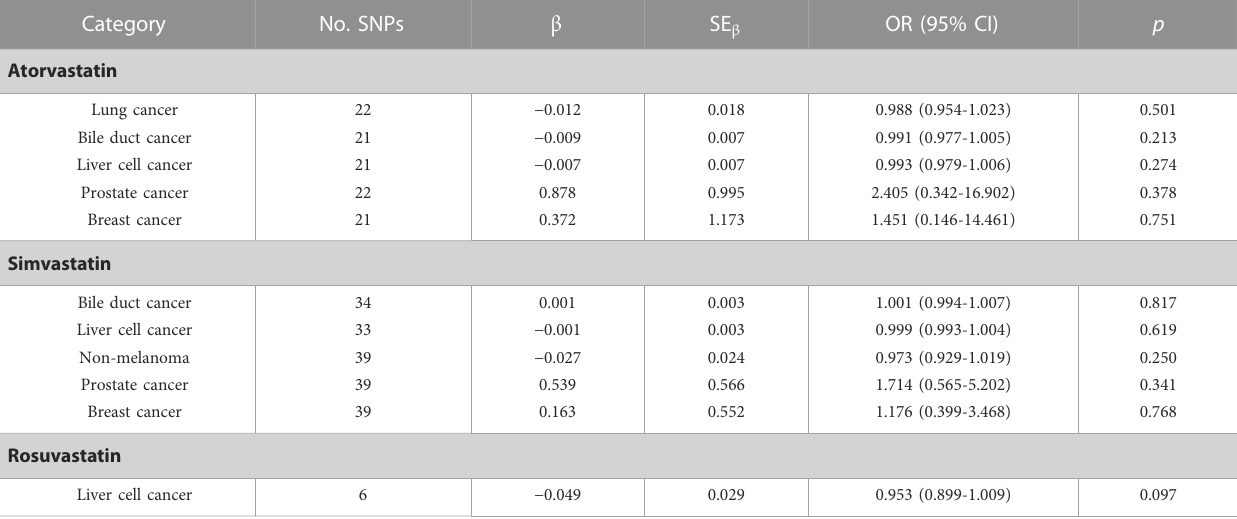
TABLE 5 Two sample MR analysis results of causality between three exposure groups and pan-cancer via multiplicative random effects IVW model method. Category No. SNPs β SE β OR (95% CI) Atorvastatin Lung cancer